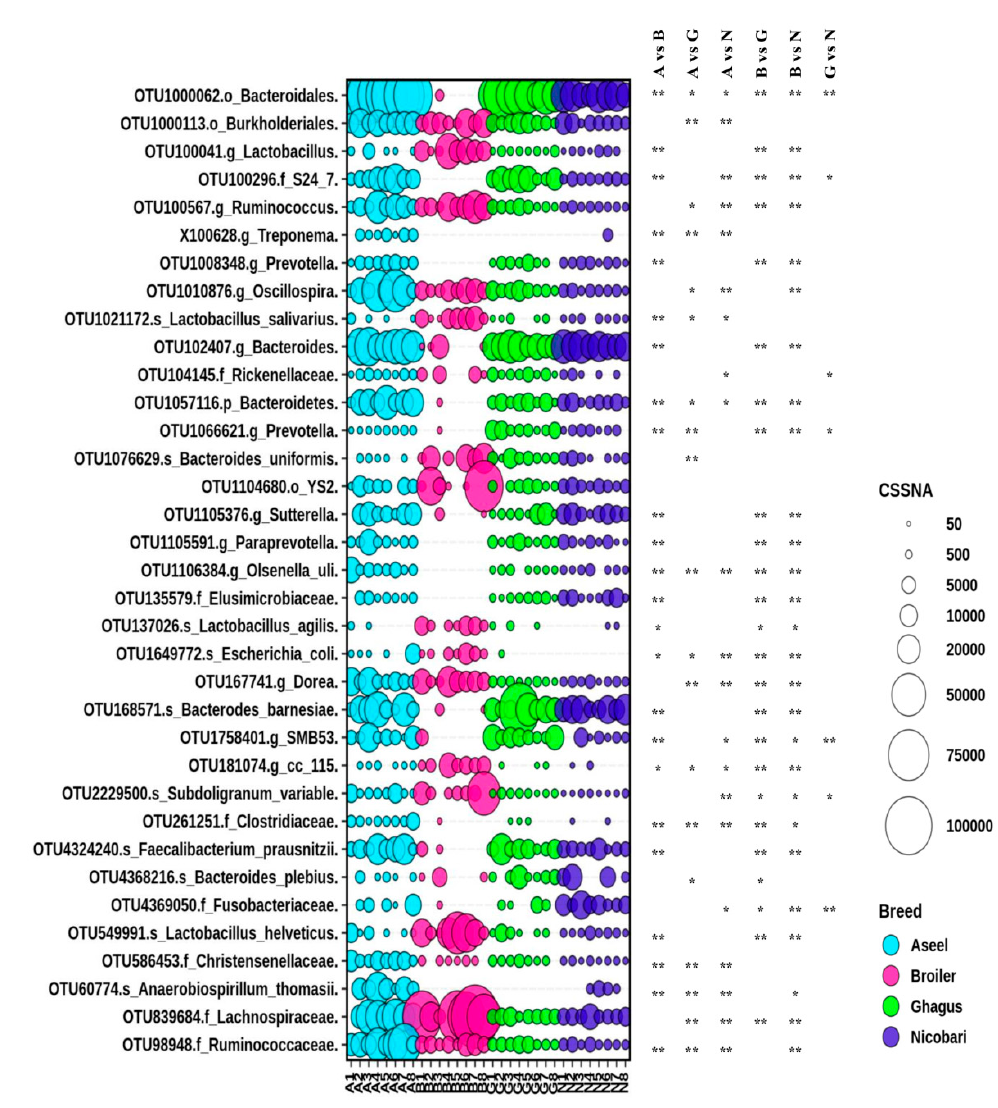
Figure 4. Differential abundance of gut microbiota in different breeds or lines at OTU level. Top 35 abundant phylotype-OTUs, out of 88 phylotype-OTUs with a significant difference in relative abundance among groups identified with edgeR, were plotted. The size of bubbles in the bubble plot indicates the normalized (cumulative sum scaling) abundance of each OTU. * p -value < 0.05; ** p -value< 0.01.